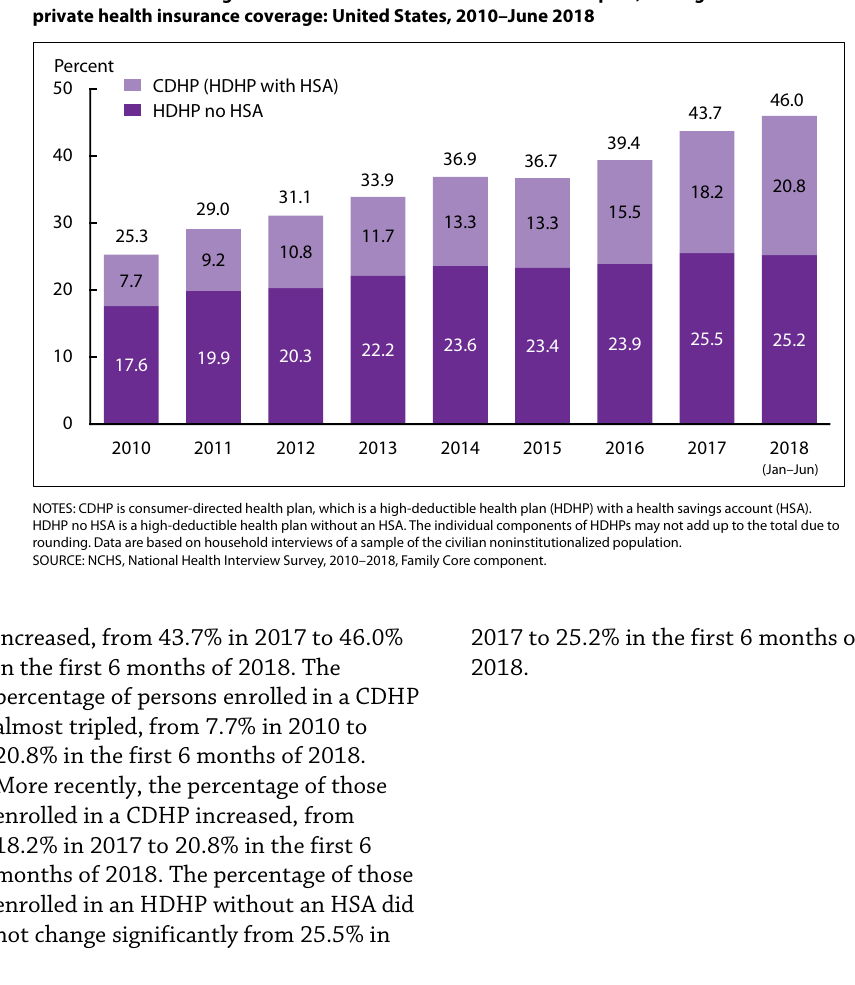
Figure 11. Percentage of persons under age 65 enrolled in a high-deductible health plan without a health savings account or in a consumer-directed health plan, among those with